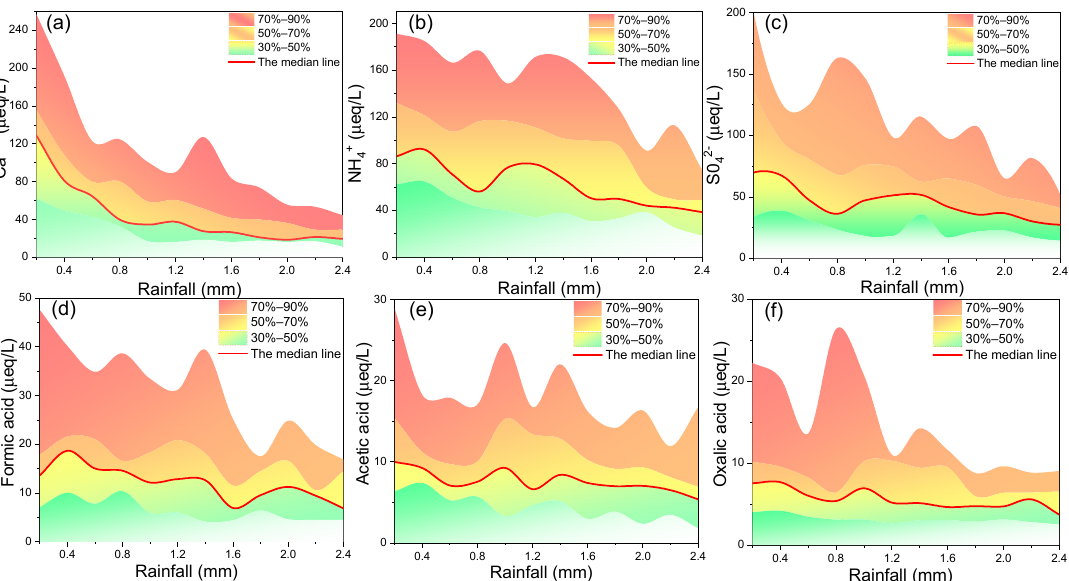
Figure 3. The changes in concentrations of ( a ) Ca 2+ , ( b ) NH 4+ , ( c ) SO 42 − , ( d ) formic acid, ( e ) acetic acid, and ( f ) oxalic acid with accumulated rainfall. The ion concentrations were divided into four percentiles to observe the ion concentrations in each concentration interval (0–30%, 30–50%, 50–70%, 70–90%).